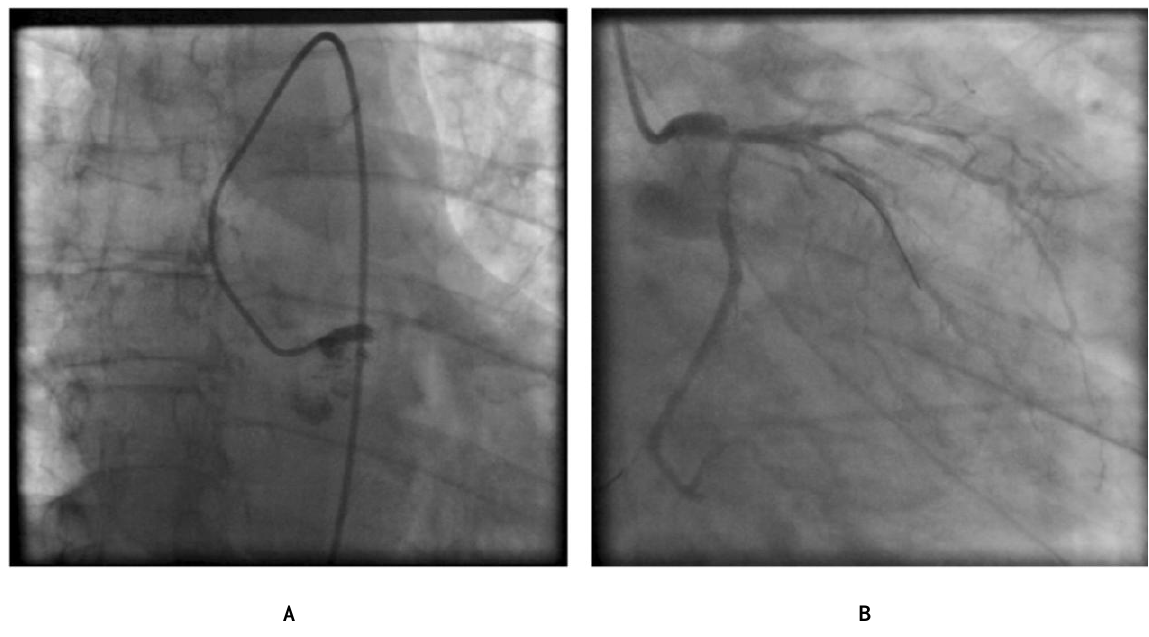
FIGURE 2. Coronary angiograms. (A) Anterior-posterior view displays a complete occlusion of the LMCA. (B) Right anterior oblique 30°/caudal 20° view displays a marginal reperfusion after rescue angioplasty of the